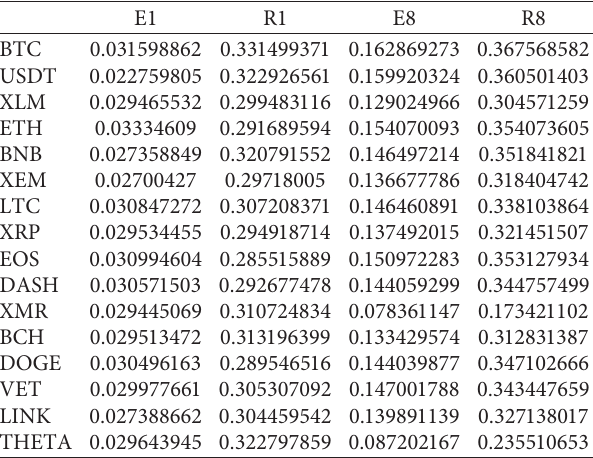
Table 7: Variance decomposition under D1 and